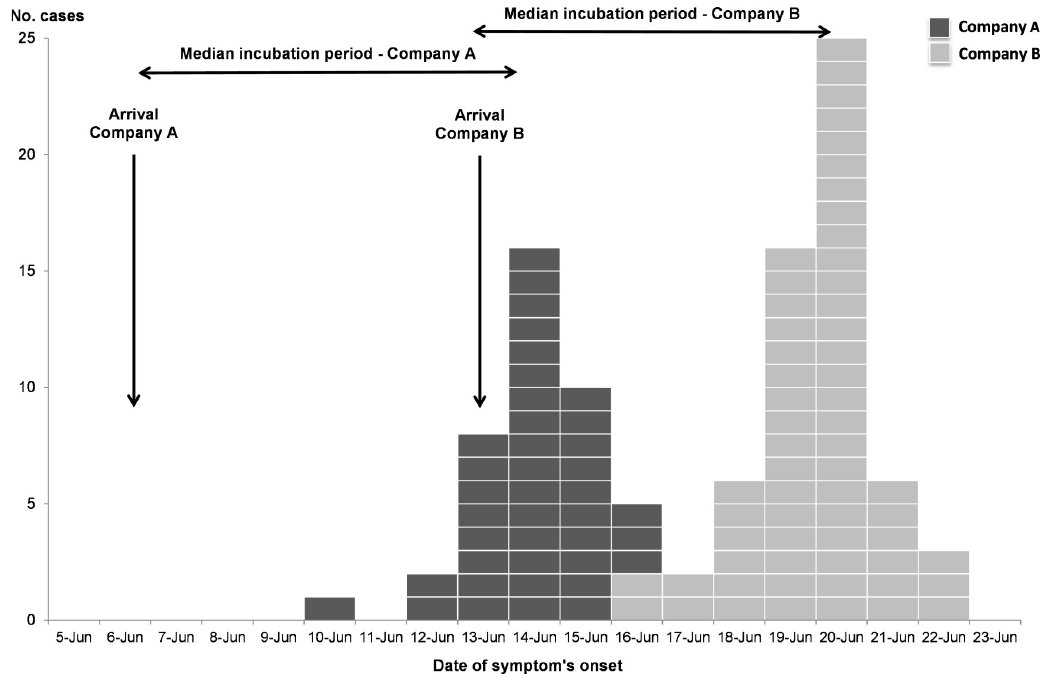
Fig 2. Cryptosporidiosis outbreaks in two companies of the French Armed Forces, epidemic curve, France, 2017, (N = 100 cases).